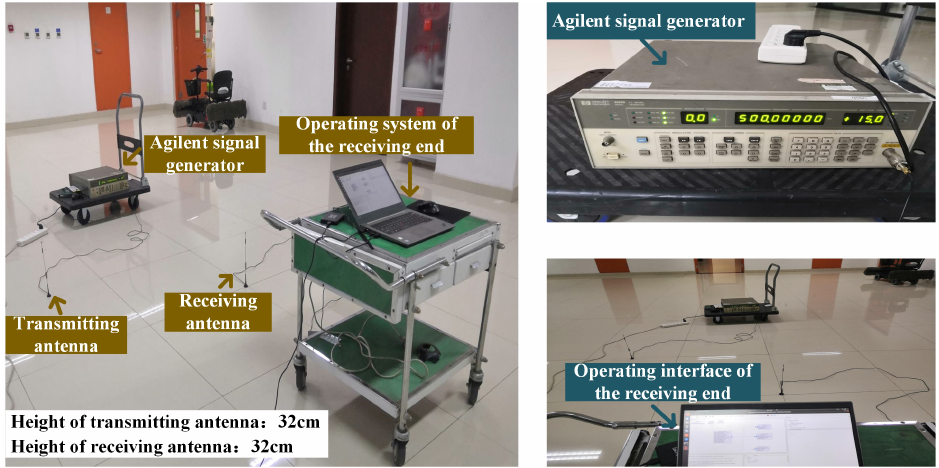
Figure 8. The site of real experiment.